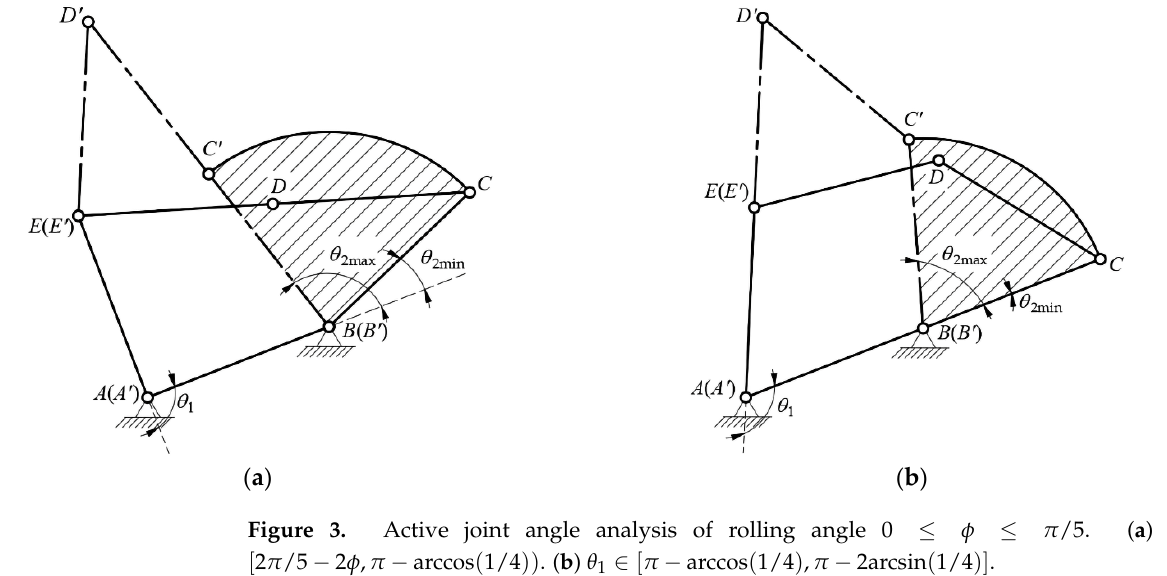
( b ) Figure 4. Active joint angle analysis of rolling angle 𝜋 /5 (cid:3407) 𝜙 (cid:3409) 2 𝜋 /5 . (a) 𝜃 (cid:2870) ∈ (cid:4670) 2 𝜋 /5 (cid:3398) 2 𝜙 , 𝜋 (cid:3398) arccos (cid:4666) 1/4 (cid:4667)(cid:4667) . (cid:4666) b (cid:4667) 𝜃 (cid:2870) ∈ (cid:4670)𝜋 (cid:3398) arccos (cid:4666) 1/4 (cid:4667) , 𝜋 (cid:3398) 2arcsin (cid:4666) 1/4 (cid:4667) (cid:4671) .